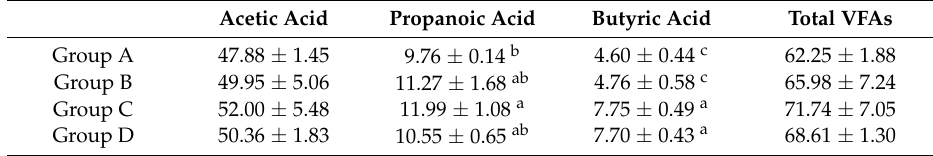
Table 5. Effect of intragastric administration with C. butyricum Sx-01, L. salivarius C-1-3 and a combination thereof on blood excrement VFAs concentration of mice (Day 5).